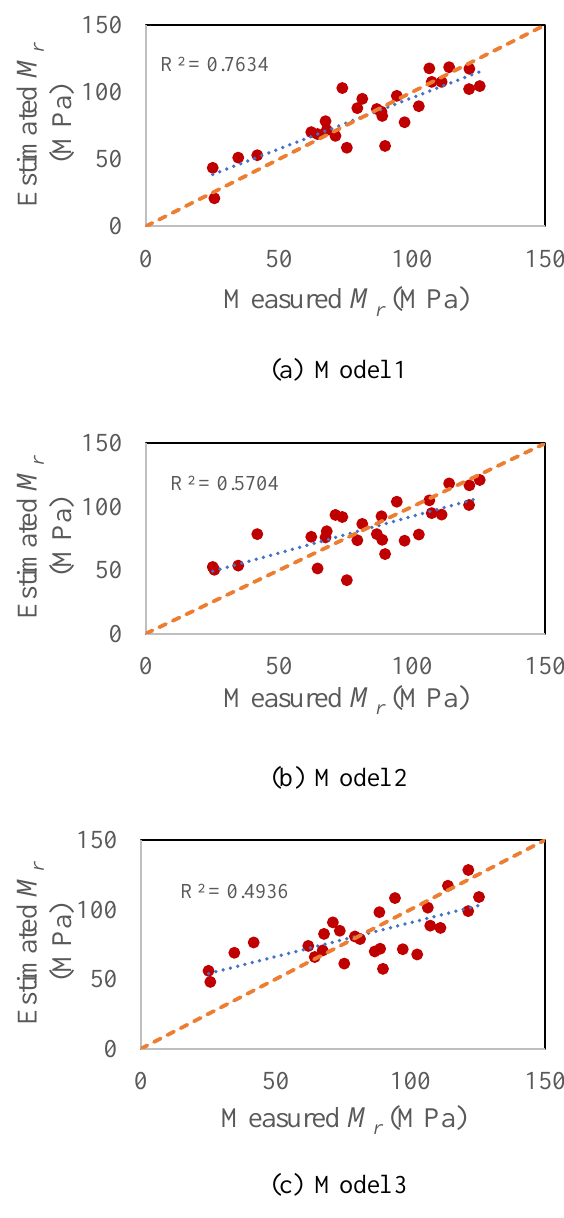
Figure 5. Estimated and Measured Resilient Modulus: ( a ) Model 1 is a correlation between M r and E avg , MC, OMC, DUW, MDUW ( b ) Model 2 is a correlation between M r and q u , S 1% , ( c ) Model 3 is a correlation between M r and E avg.